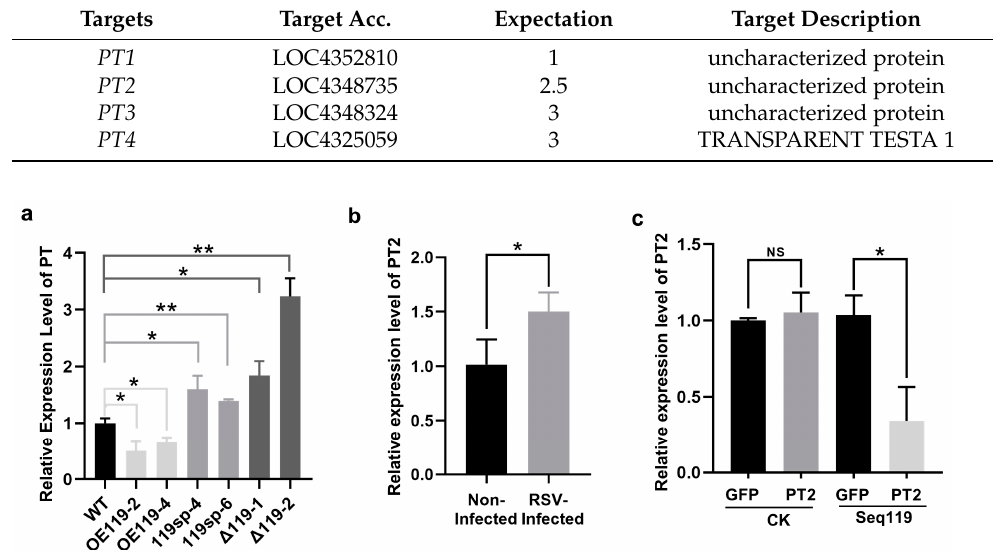
Figure 5. Identification of the target of Seq119: ( a ) Relative expression levels of the predicted target (PT) of Seq119 in WT, OE119, 119sp and ∆ 119 plants (* p < 0.05, ** p < 0.01). ( b ) Relative expression levels of PT2 of Seq119 in RSV-infected rice (* p < 0.05). ( c ) Relative expression level of PT2-GFP or mRT2-GFP in analysis expressing Seq119 or a control small RNA (CK) as detected by qRT-PCR (* p < 0.05; NS: no significance).